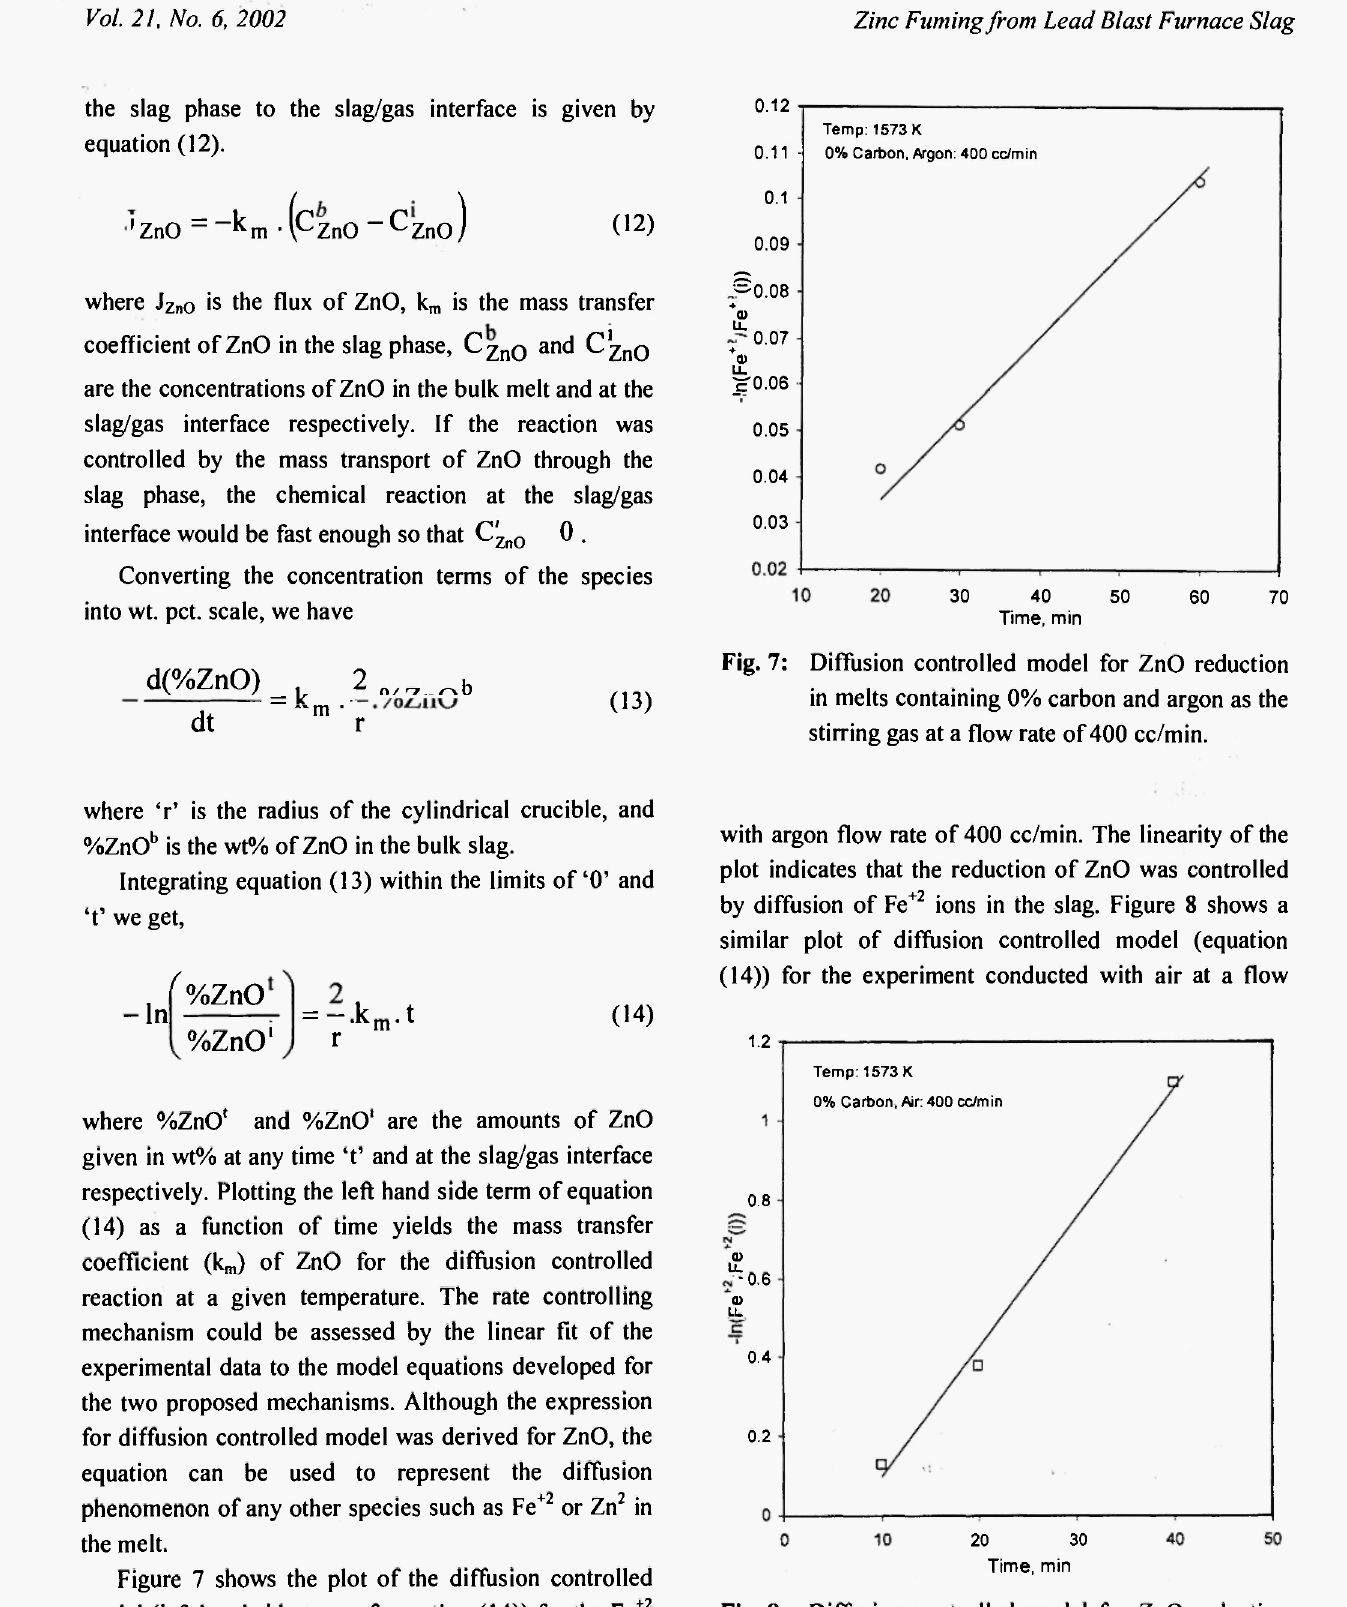
Fig. 8: Diffusion controlled model for ZnO reduction in melts containing 0% carbon and air as the stirring gas at a flow rate of 400